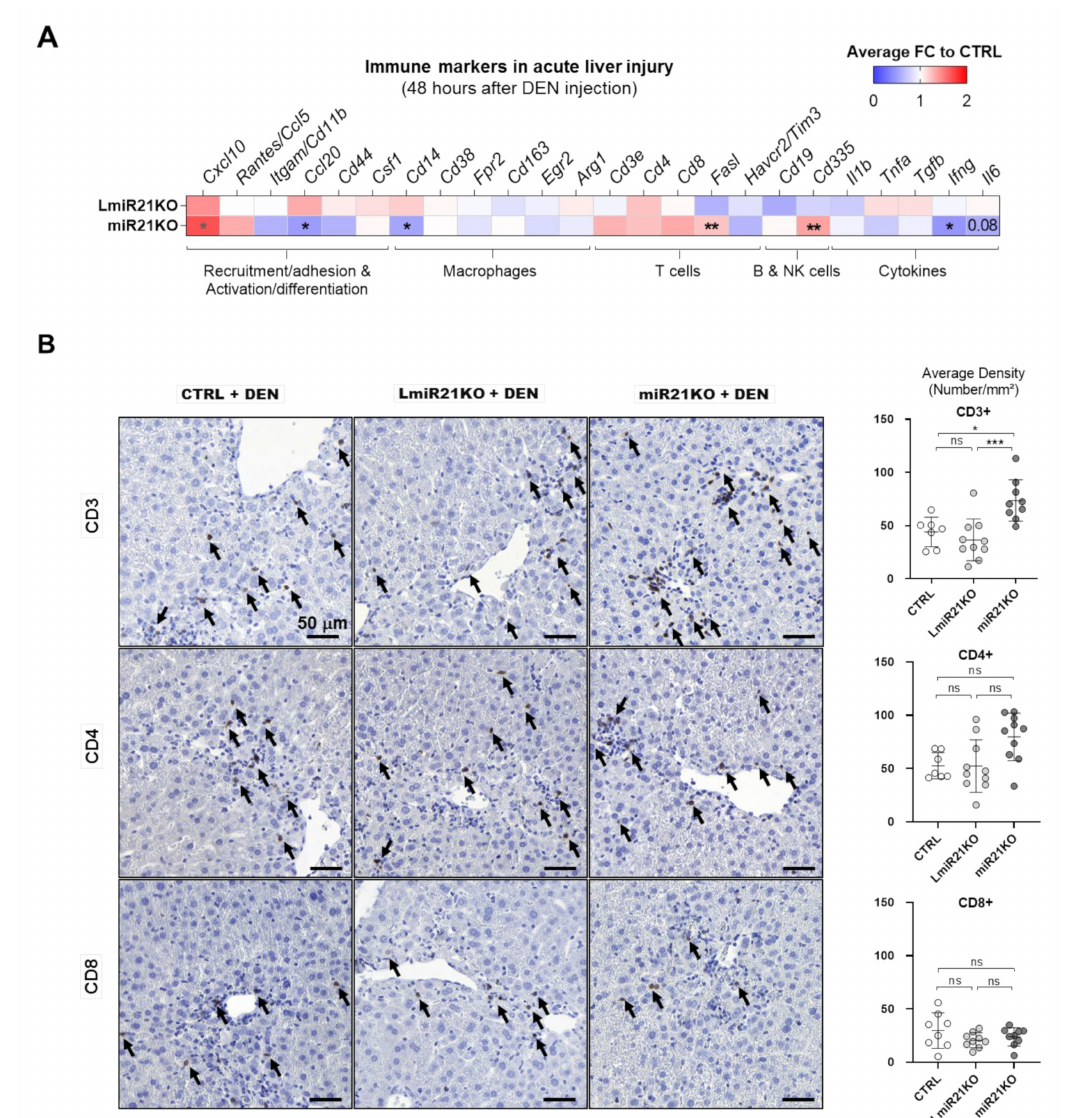
Figure 6. MiR-21 deficiency alters DEN-induced acute inflammatory responses and immune cells recruitment in the liver prior to tumor initiation. ( A ) Heatmap representation of relative mRNA expression of inflammatory markers involved in immune cell recruitment, adhesion, activation, and differentiation; of macrophages, T cells, B cells and NK cells; and of pro- and anti-inflammatory cytokines in non-tumoral hepatic tissues from 2-month-old mice 48 h post-DEN injection (100 mg/kg of body weight; CTRL, n = 9 mice, LmiR21KO, n =10 mice; miR21KO mice, n = 10 mice). Data are represented by mean fold-change (FC) to CTRL (miR21fx treated with DEN). ( B ) Representative immunohistochemical staining of CD3, CD4 and CD8 in liver sections (left) and quantification of positive cells (number of positive cells per mm 2 , right) in DEN-injected mice (CTRL, n = 8; LmiR21KO, n = 5–10, miR21KO, n = 7–9). Data is represented as mean ± SD. Data that failed normality tests was submitted to log10-transformation prior to statistical analysis. An outliers test was performed using the ROUT method (Q = 1%). One-way ANOVA with Holm–Sidak’s correction was used for comparison between more than two groups with one variable. * p -value <0.05, ** p -value < 0.01, *** p -value <